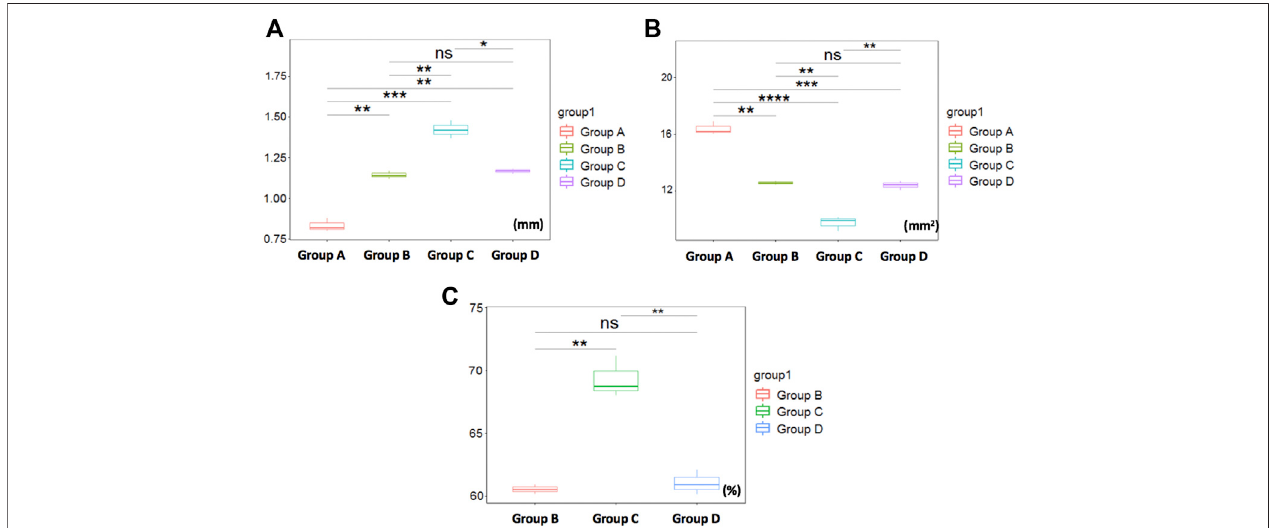
FIGURE 4 | Comparison of tracheal measurements by PAT. (A) The TWT values in group C can be easily visualized as larger than in groups A***, B**, and D *, respectively. (B) showingCSAingroupCwasdecreasedmostamongthefourgroups,comparedwithgroupA****,B**andD**,respectively. (C) showingSRingroupC was most severe among the stenosis groups, compared with group B** and D**. Otherwise, no signi fi cant differences were found between group B and D measurements. * p < 0.05, ** p < 0.01, *** p < 0.001, **** p < 0.0001, ns p > 0.05.